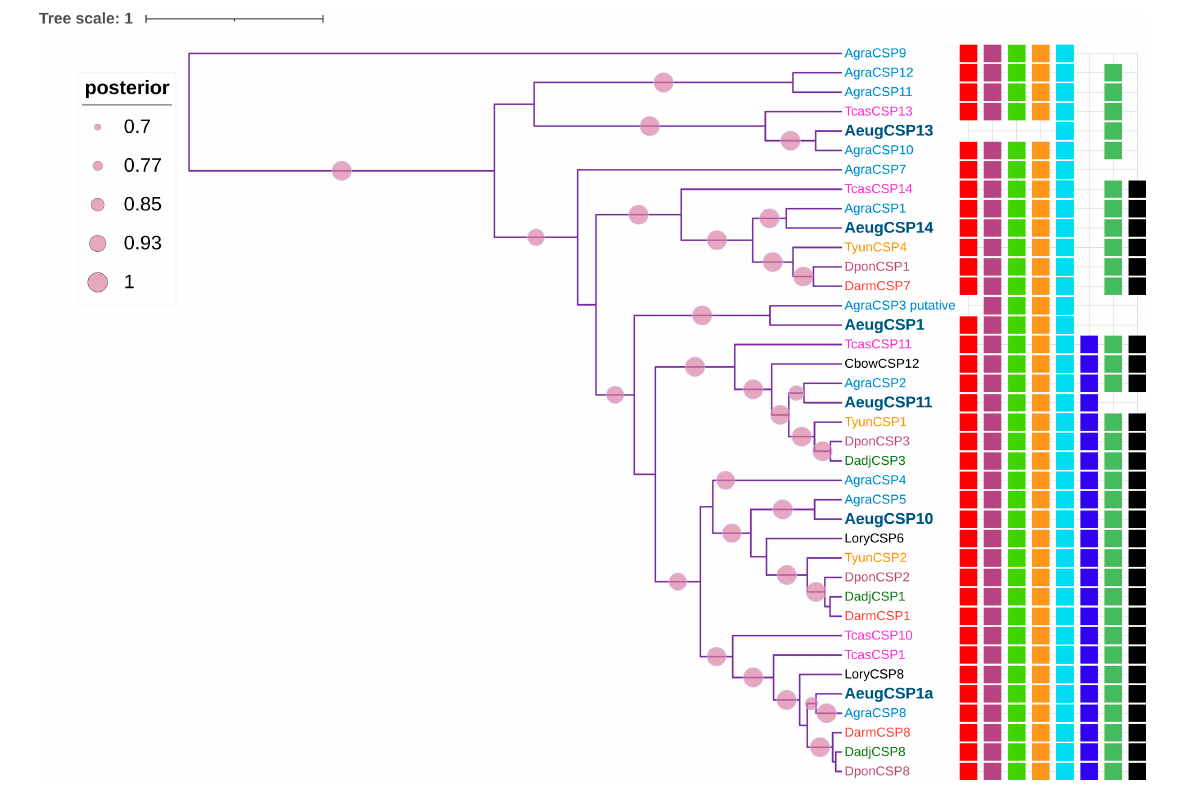
Figure 4. CSPs phylogeny by Bayesian inference. Motif patterns were assigned to each sequence, and motif’s colors correspond to those described in Figure S4. Species: Anthonomus eugenii (Aeug), A. grandis (Agra), Colaphellus bowringii (Cbow), Sitophilus zeamais (Szea), Dendroctonus adjunctus (Dadj), D. ponderosae (Dpon), Tribolium castaneum (Tcas), Tomicus yunannensis (Tyun), Lissorhoptrus oryzophilus (Lory).